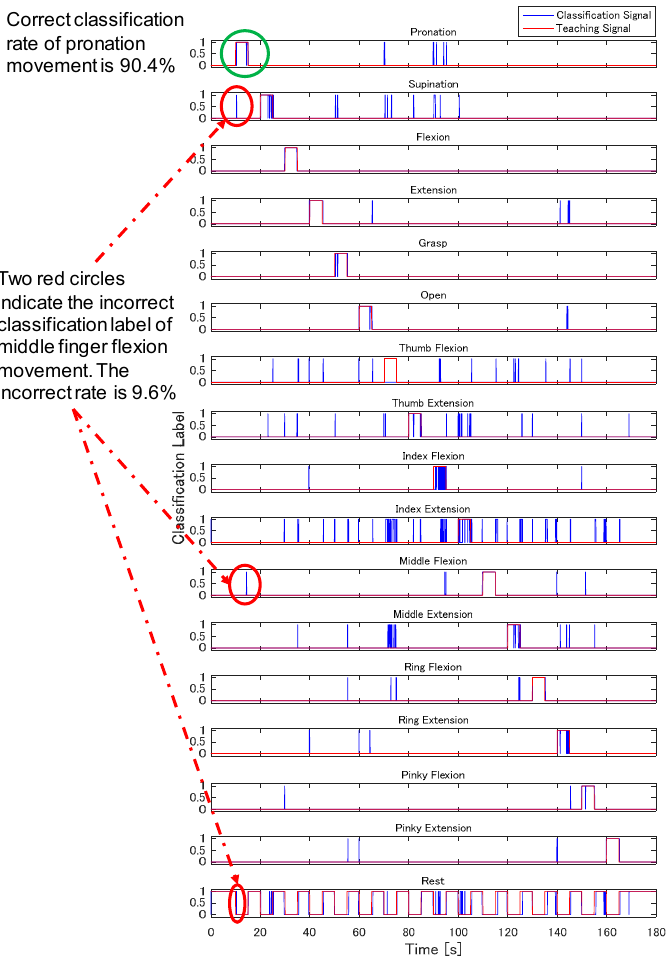
Figure 9. Example of a classification output. The blue line indicates the classification signal. The red line indicates teaching signals. The green circle represents correct classification label of pronation movement as an example. The red circle indicates the incorrect classification label of pronation movement. In this study, the artificial neural network (ANN) classifier gives a decision every 0.005 s (200 Hz).